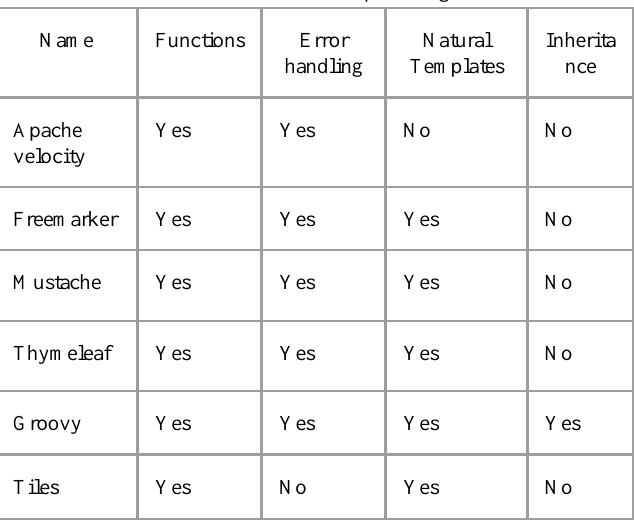
Table 1. Features of Template